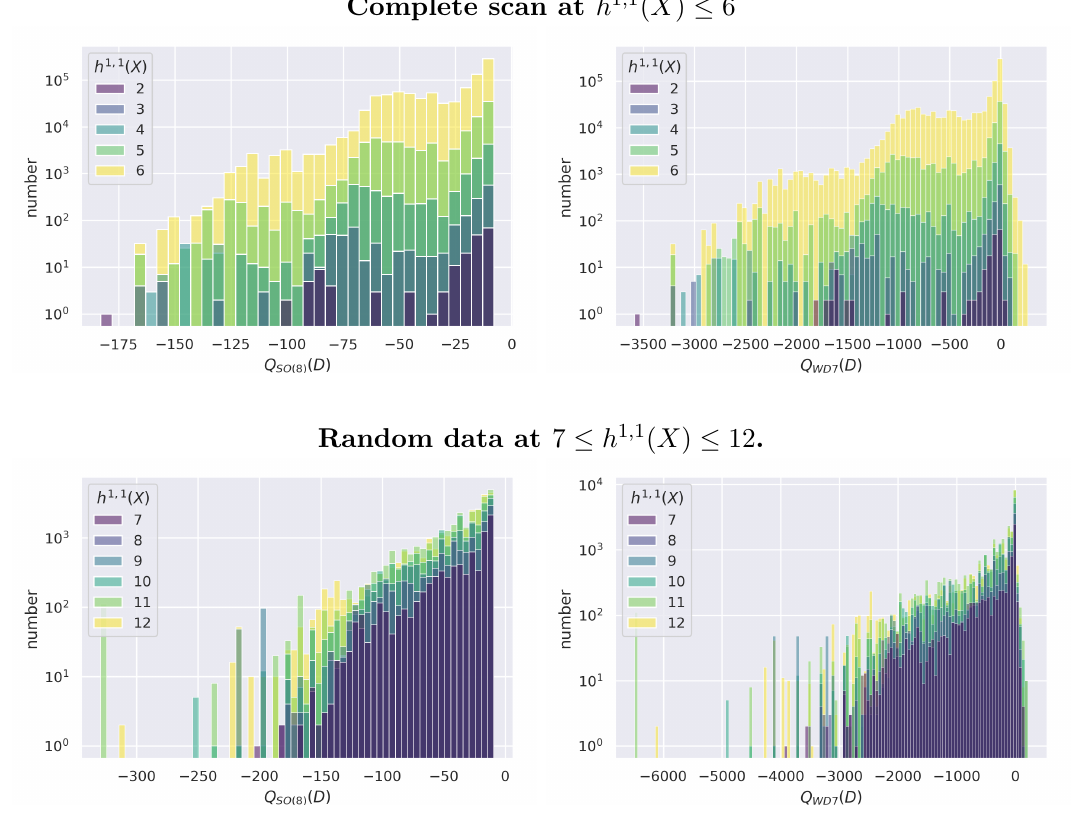
Figure 4 . Local vs. non-local tadpole cancellation for data at h 1 , 1 ( X ) ≤ 6 . Left: distribution of ( D ) for divisors with h 0 , 2 ( D ) > 1 and h 0 , 1 ( D ) = 0 . Right: distribution of Q Q SO (8) same